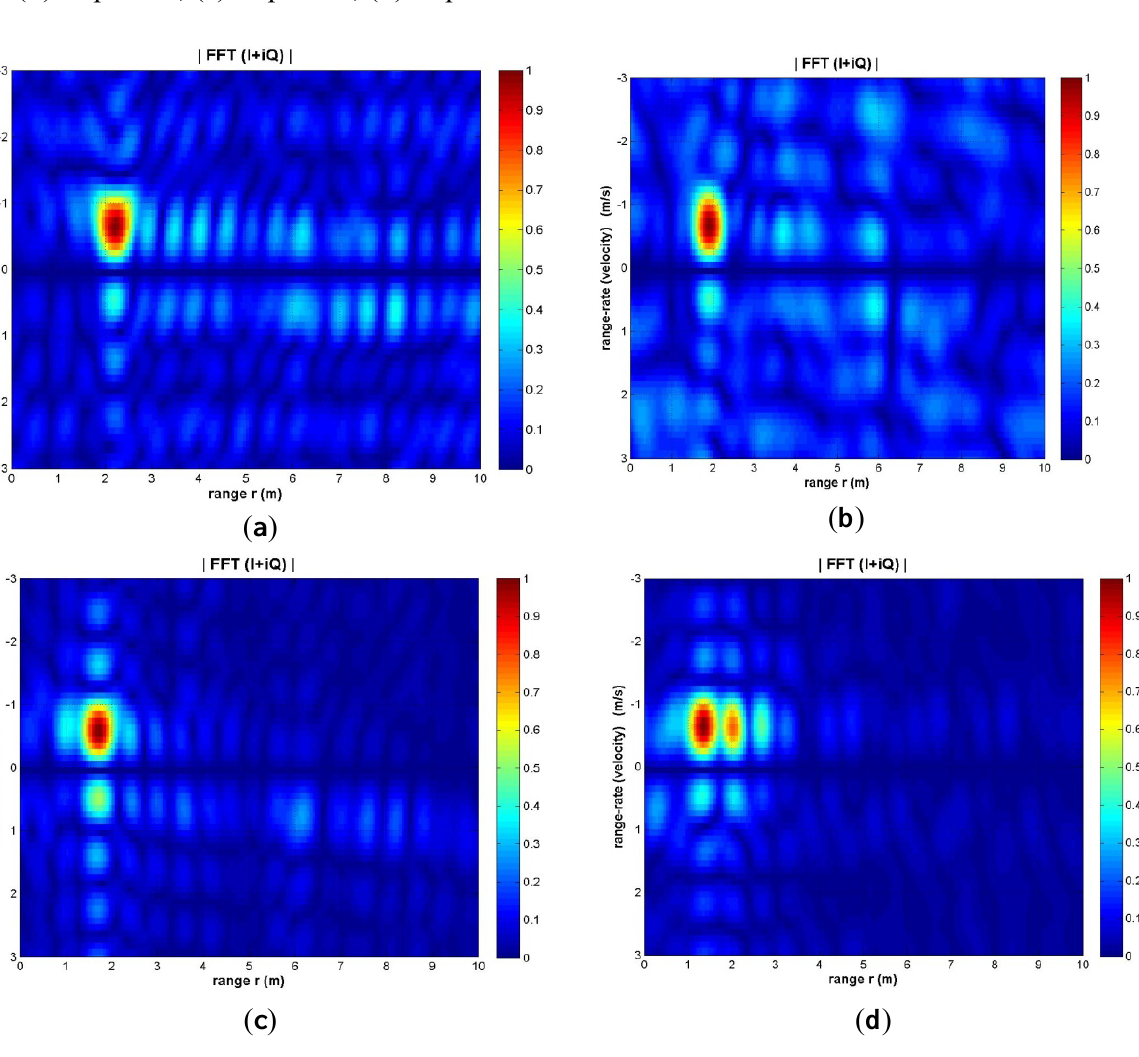
Figure 7. Range and velocity intensity plots for target tracking experiment: ( a ) Capture 1; ( b ) Capture 2; ( c ) Capture 3; ( d ) Capture